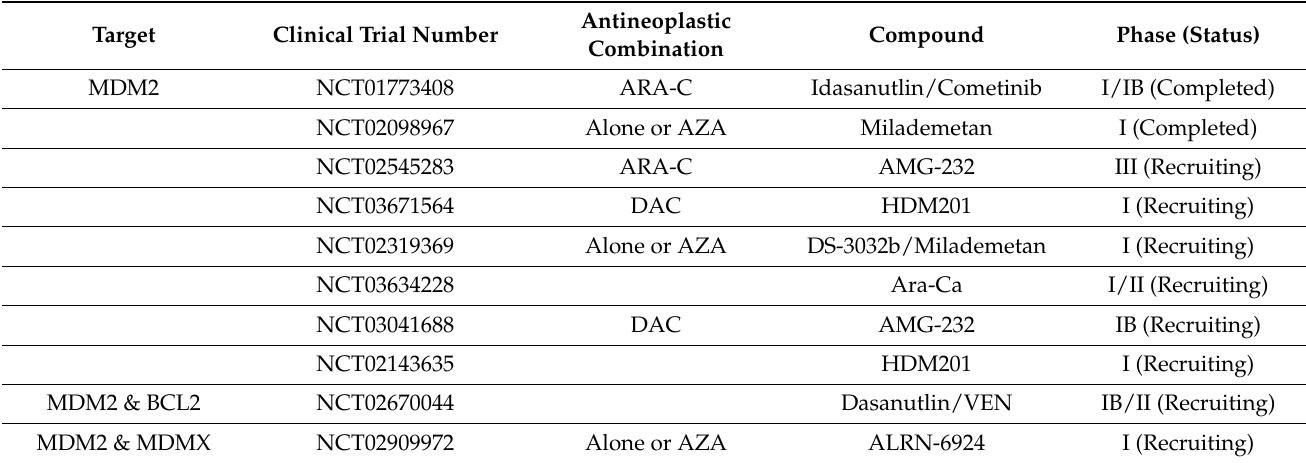
Table 1. Clinical trials to restore wild type function of p53.